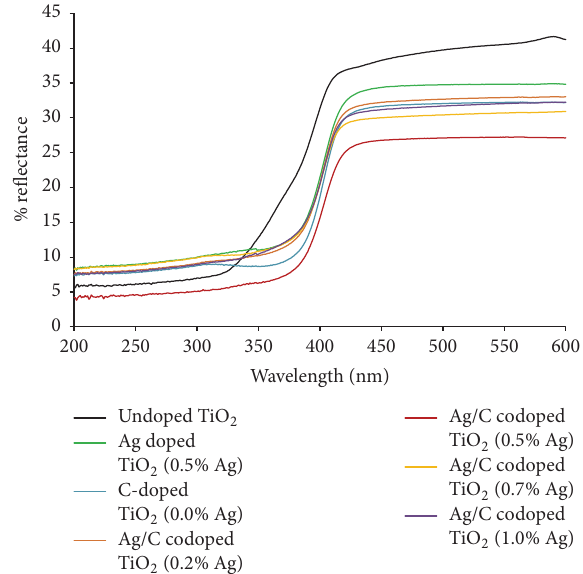
Figure 5: UV-Vis diffuse reflectance spectra of undoped TiO 2 , Ag doped TiO 2 , C-doped TiO 2 , and Ag/C codoped TiO 2 photocatalysts with different Ag loadings.